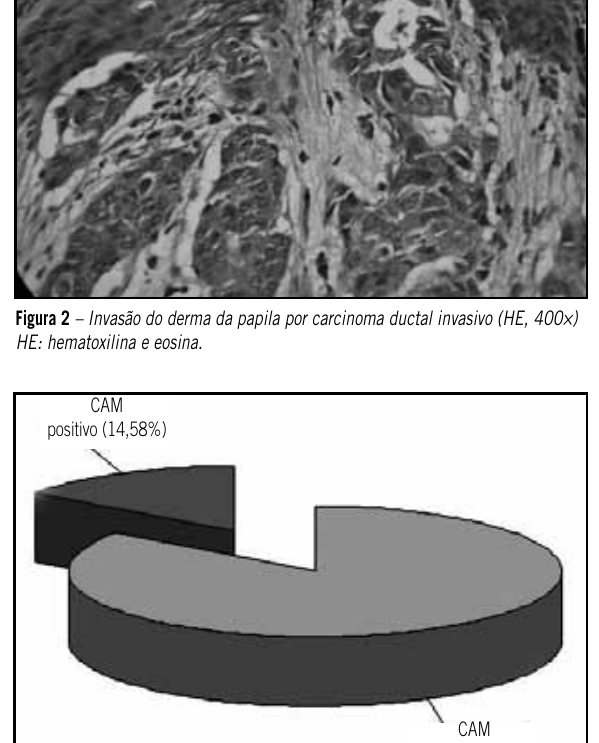
CAM negativo (85,42%)